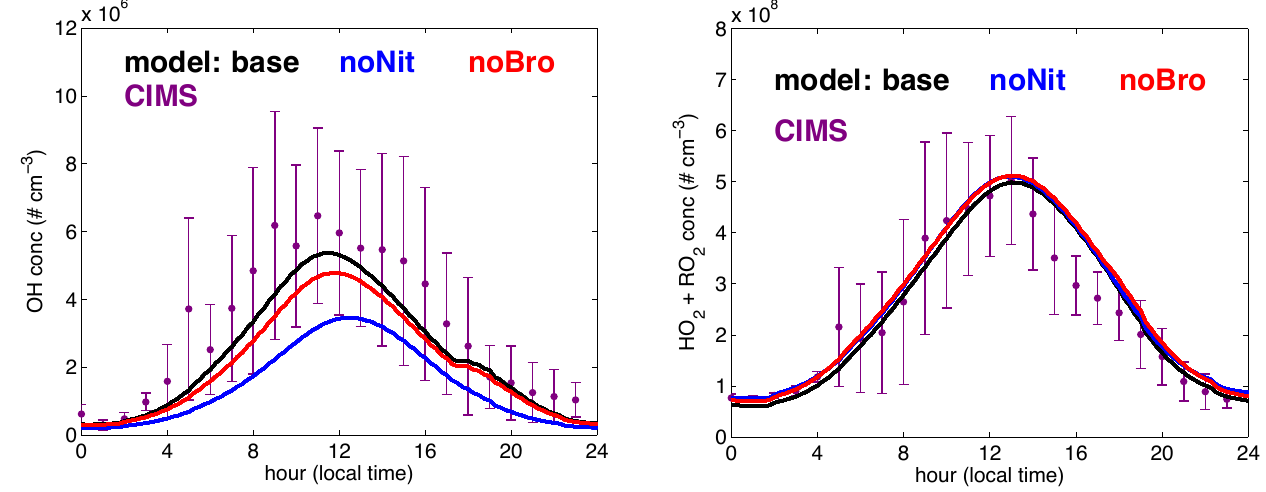
Fig. 11. Model predicted HO 2 +RO 2 (where RO 2 represents the sum of all organic peroxyl radicals for both the measurement and the model) concentrations for the second day of a three day model run for the base, noNit, and noBro cases compared to hourly aver- aged HO 2 +RO 2 concentrations for the time periods classified as influenced by local air. The error bars on the HO 2 +RO 2 measure- ments indicates the standard deviation upon hourly